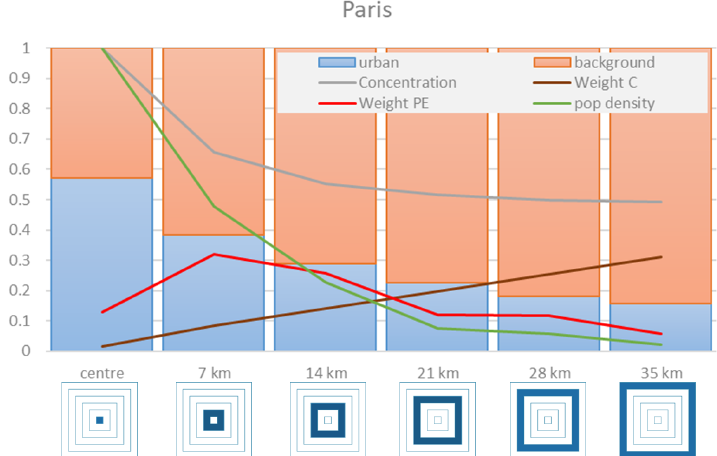
Figure 5. City rings’ source apportionment for Paris PM 2 . 5 and associated population exposure. The city and background apportionment (bars) is represented for rings ( i ) progressively more distant from the city centre ( x axis). The ring average concentration ( C i ) and population density ( P i ) relative to the city centre values are represented in blue and green, respectively. The relative (to the FUA total, i.e. all rings) weight of each ring (i) in the city average concentration (brown) is calculated as C i × S i / (cid:80) i ( C i × S i ), where S i is the ring area. A similar expression ( C i × S i × P i / (cid:80) i ( C i × S i × P i )) is used to determine the weight of each ring in the calculation of the average population exposure (red